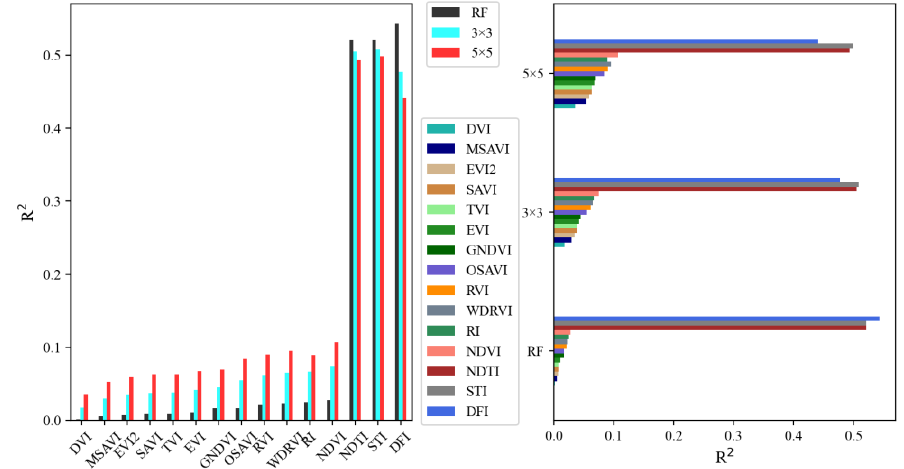
c Figure 7. Comparison of GF - 1 experimental sample CRC RF -RVI before and after the removal of outliers (elimination of outliers from the boxplot ( b ), before ( a ), after ( c )). 3.3. Sensitivity Analysis of Spectral Index to CRC in Wheat Based on Sentinel-2 Image Data In this experiment, we combined sentinel-2 remote sensing data and extracted rele- vant spectral information of the experimental area. Through analysis, it was found that the NDTI, DFI and STI performed well in the univariate regression model, and the high- est determination coefficient ( R 2 ) was 0.54. However, the spectral index RVI synthesized by Sentinel-2 in the visible – near-infrared band range was not as accurate as the CRC- RVI model constructed by the GF-1 data and had almost no correlation. A machine